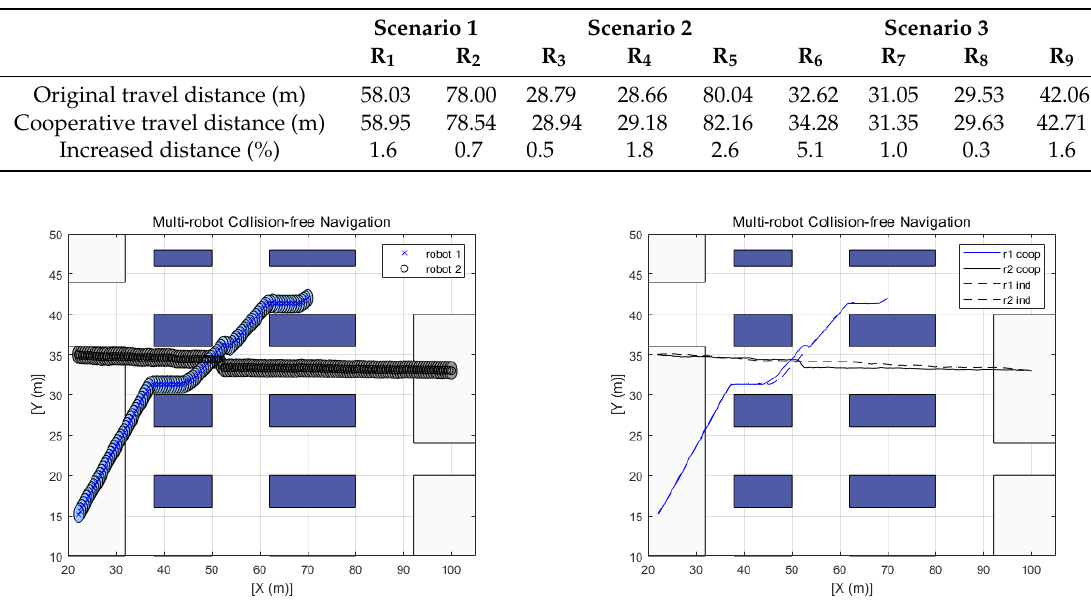
Table 8. Simulation results of multi-robot navigation.